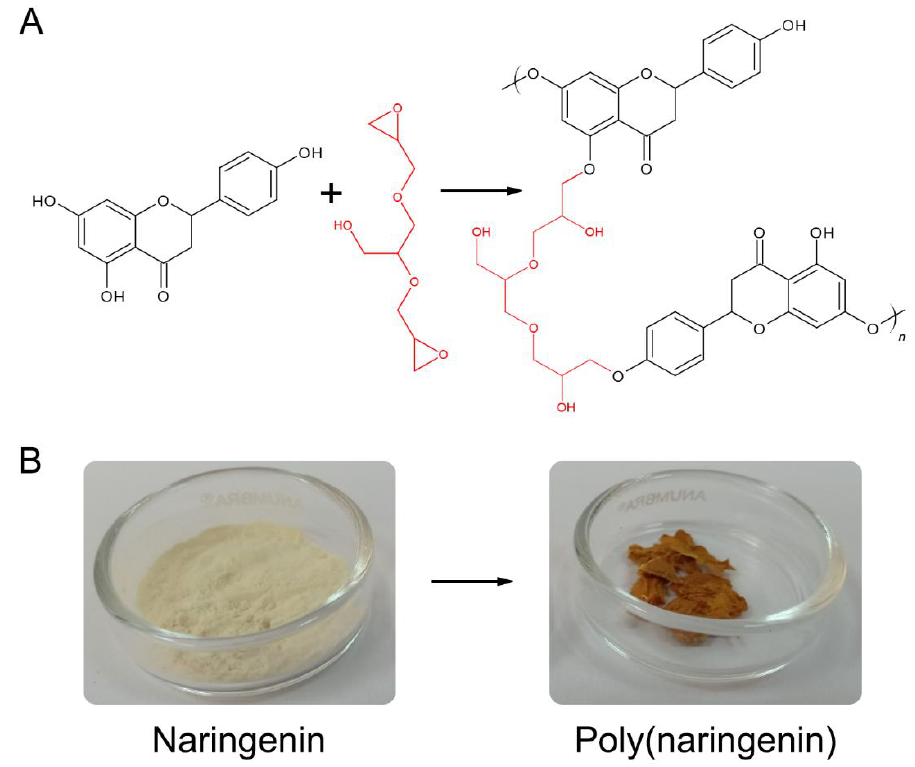
Figure 2. Proposed scheme of cross-linking reaction of naringenin with glycerol diglycidyl ether (GDE), where n — number of mers in poly(naringenin) ( A ); visual change of color of naringenin during polymerization with GDE (digital camera photos, Canon INC, Tokio, Japan) ( B ).